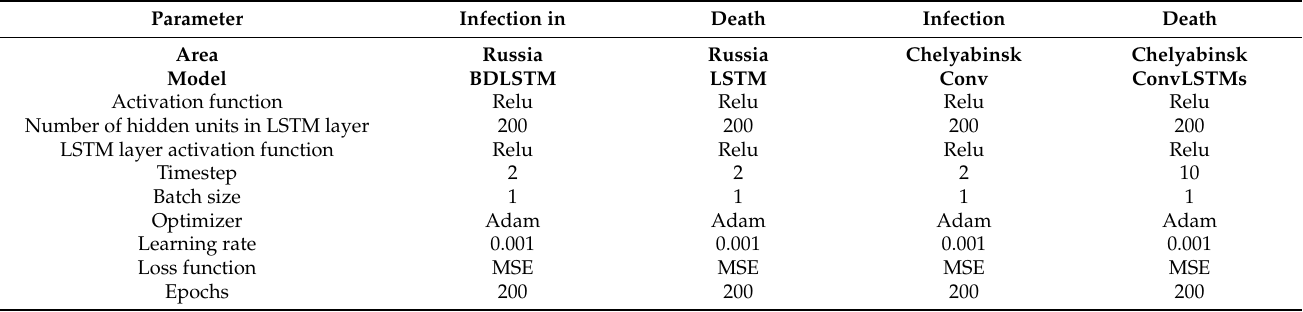
Figure 13. Comparison of the forecasting SARS-CoV-2 death cases and the real infection cases for CNN-LSTMs. Table 3. Hyper-parameter setting for models.